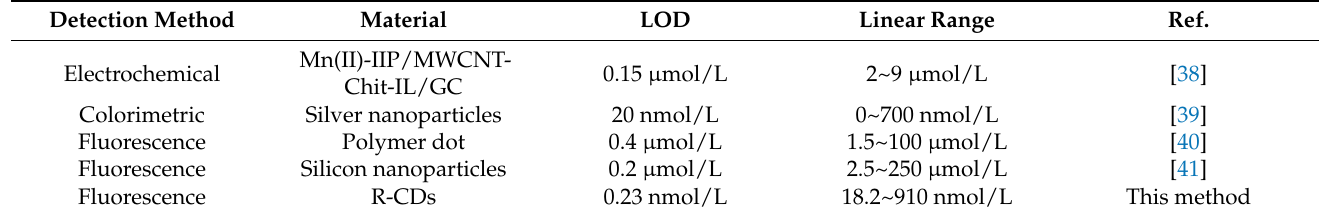
Table 1. Comparison between this method and other methods for the detection of Mn 2+ .